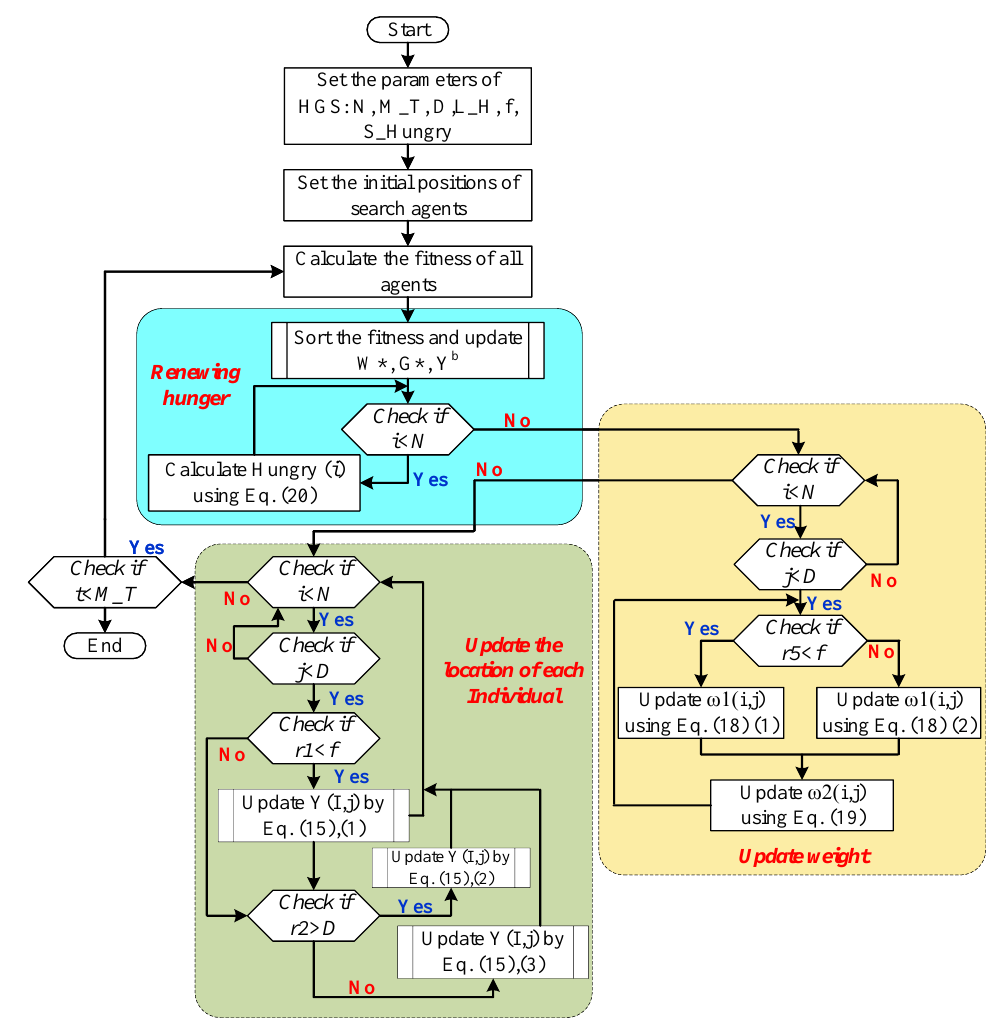
Figure 7. Flowchart of basic